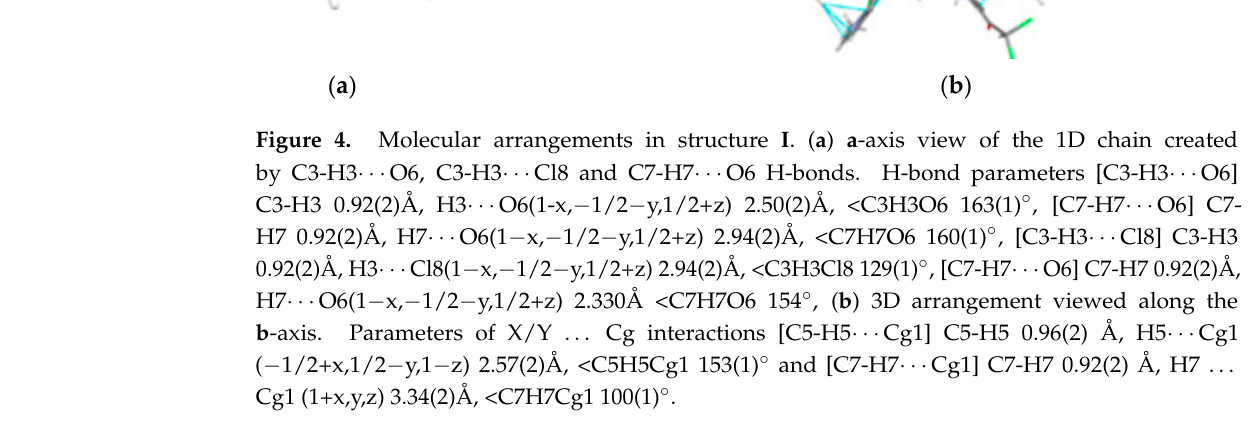
Figure 4. Molecular arrangements in structure I . ( a ) a -axis view of the 1D chain created by C3-H3 ⋯ O6, C3-H3 ⋯ Cl8 and C7-H7 ⋯ O6 H-bonds. H-bond parameters [C3-H3 ⋯ O6] C3-H3 0.92(2)Å, H3 ⋯ O6(1-